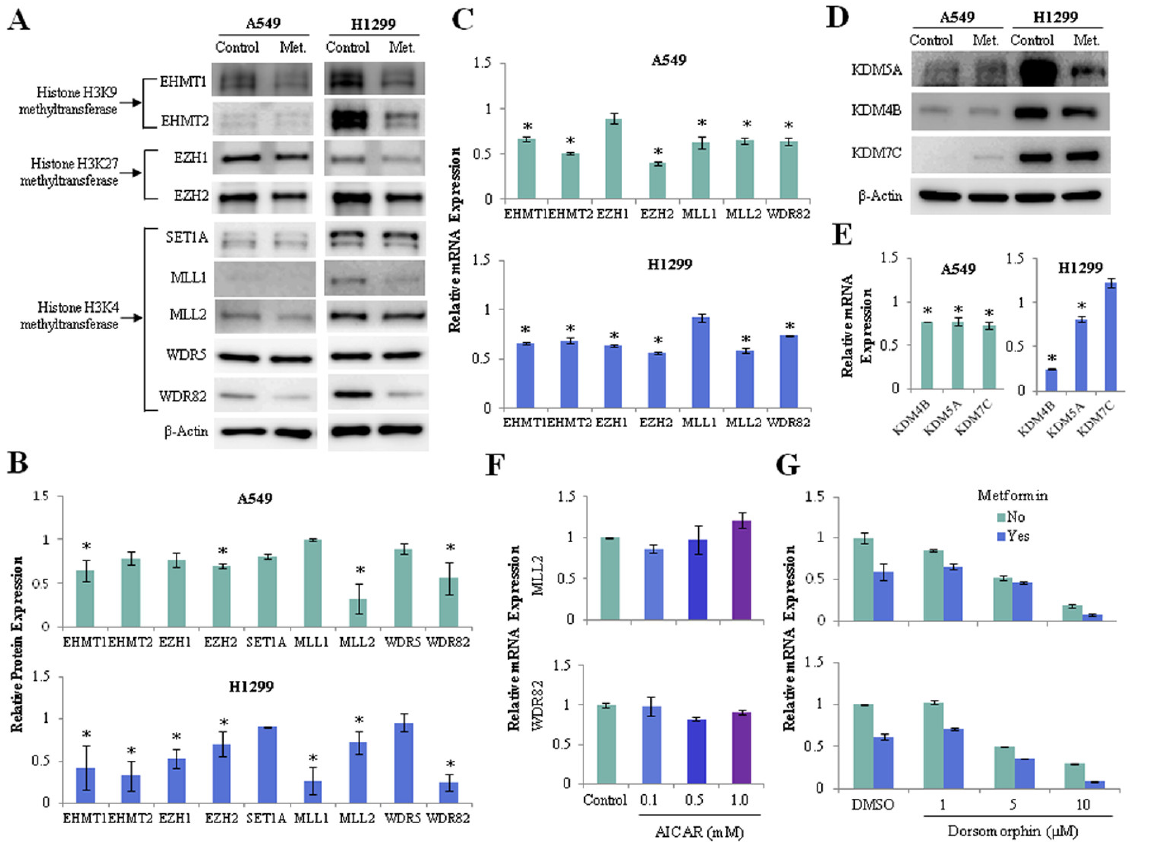
Figure 3. Effects of metformin on the expression of histone H3 methyltransferase and demethylase. H1299 and A549 cells were treated with 5mM metformin or left untreated as controls. ( A ) Protein levels of the H3K4 methyltransferases SET1A, MLL1, MLL2, WDR5, and WDR82; the H3K9 methyltransferases EHMT1 and EHMT2; and the H3K27 methyltransferases EZH1 and EZH2 were analyzed using western blotting. The uncropped blots of ( A ) were shown in Figure S2. ( B ) The expression levels of the methyltransferases in metformin-treated cells relative to control cells are shown. ( C ) mRNA levels of the methyltransferases were measured by qRT-PCR. The y -axis indicates the fold change in mRNA levels in metformin-treated cells compared with those in untreated control cells. ( D ) The protein levels of the H3K4 demethylase KDM5A and the H3K9 demethylases KDM4B and KDM7C were analyzed using western blotting. The expression levels of the demethylases in metformin-treated cells relative to control cells were shown in Figure S3A, and the uncropped blots of ( D ) were shown in Figure S3B. ( E ) The mRNA levels of three demethylases in metformin-treated cells relative to those in untreated cells. ( F , G ) H1299 cells were incubated with the AM P K activator AICAR or the AMPK inhibitor dorsomorphin (Dorso) with or without 5 mM metformin. The mRNA levels of MLL2 and WDR82 were measured by qRT-PCR. The error bars in all bar graphs indicate the standard deviation ( n = 3, * p < 0.05).